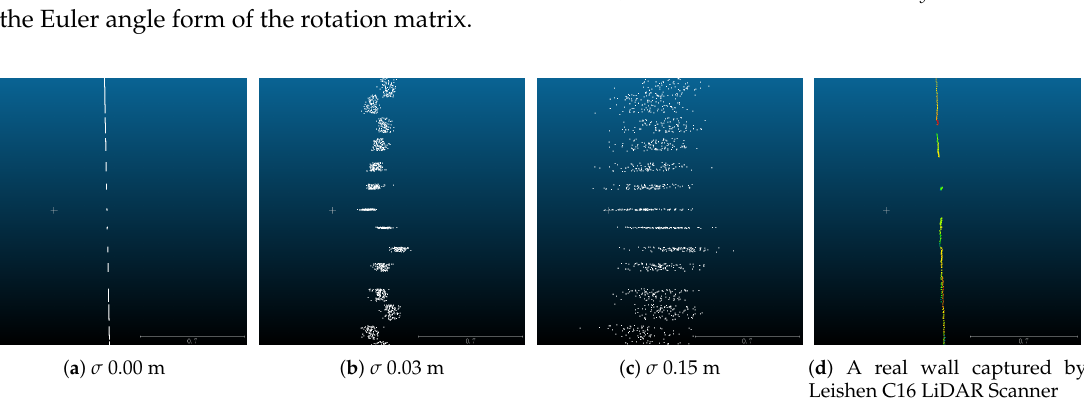
Figure 9. Side view of a wall to show noise effects on noise on point clouds. The measurement scale of the four maps is the same. The ruler at the right bottom of the images is measured in meters. The scan points on planes becomes quite noisy when σ becomes closer to 0.15 m.